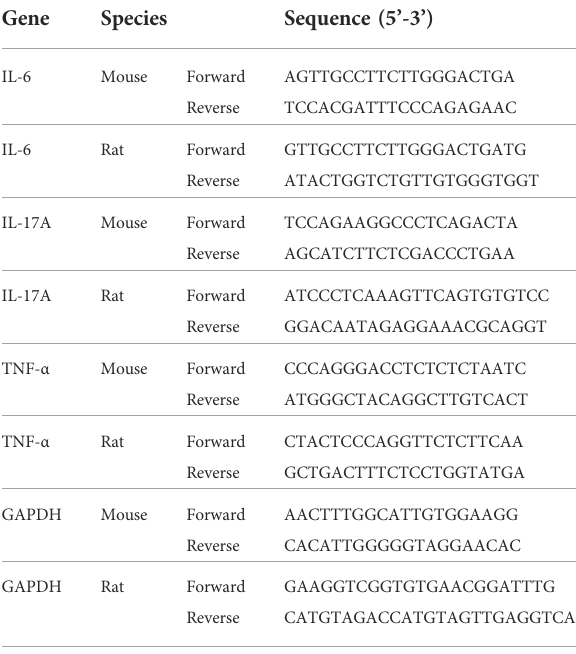
TABLE 1 Primer sequences for RT-PCR